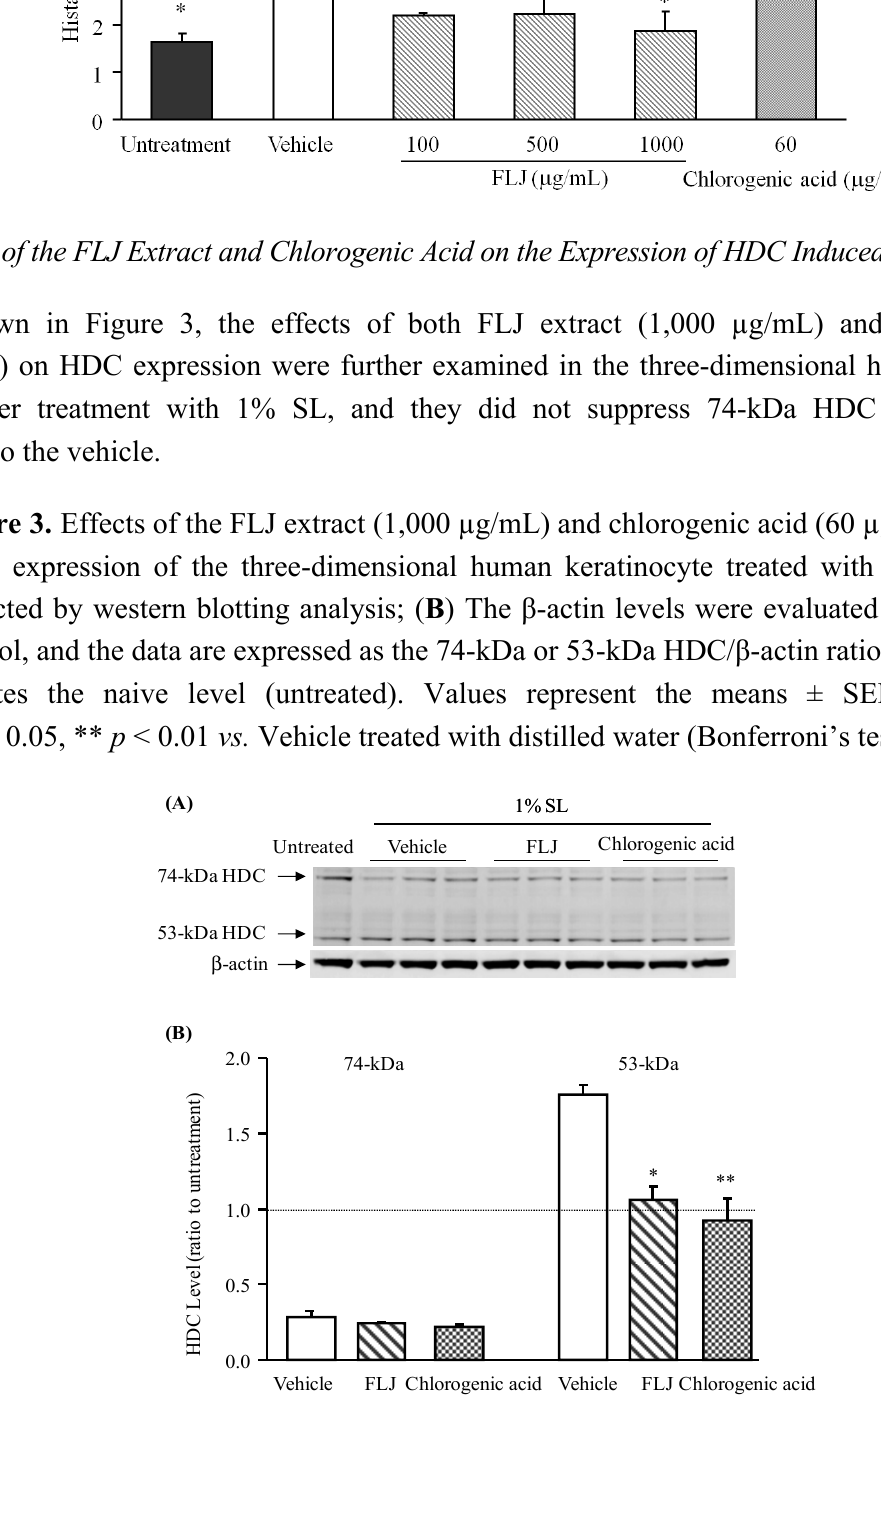
Figure 2. Effects of the FLJ extract and chlorogenic acid on the concentration of histamine enhanced by SL treatment in a three-dimensional human keratinocyte culture. Values represent the means ± SEM ( n = 3). * p < 0.05 vs. Vehicle treated with distilled water (Dunnett’s test).